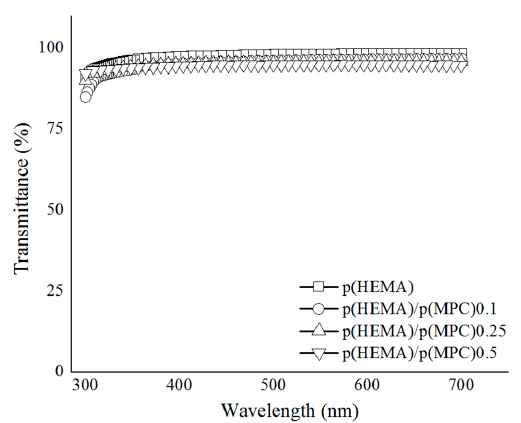
Figure 1. Transmittance spectra of the poly(2-methacryloyloxyethyl phosphorylcholine)-surface-functionalized hydrogels.